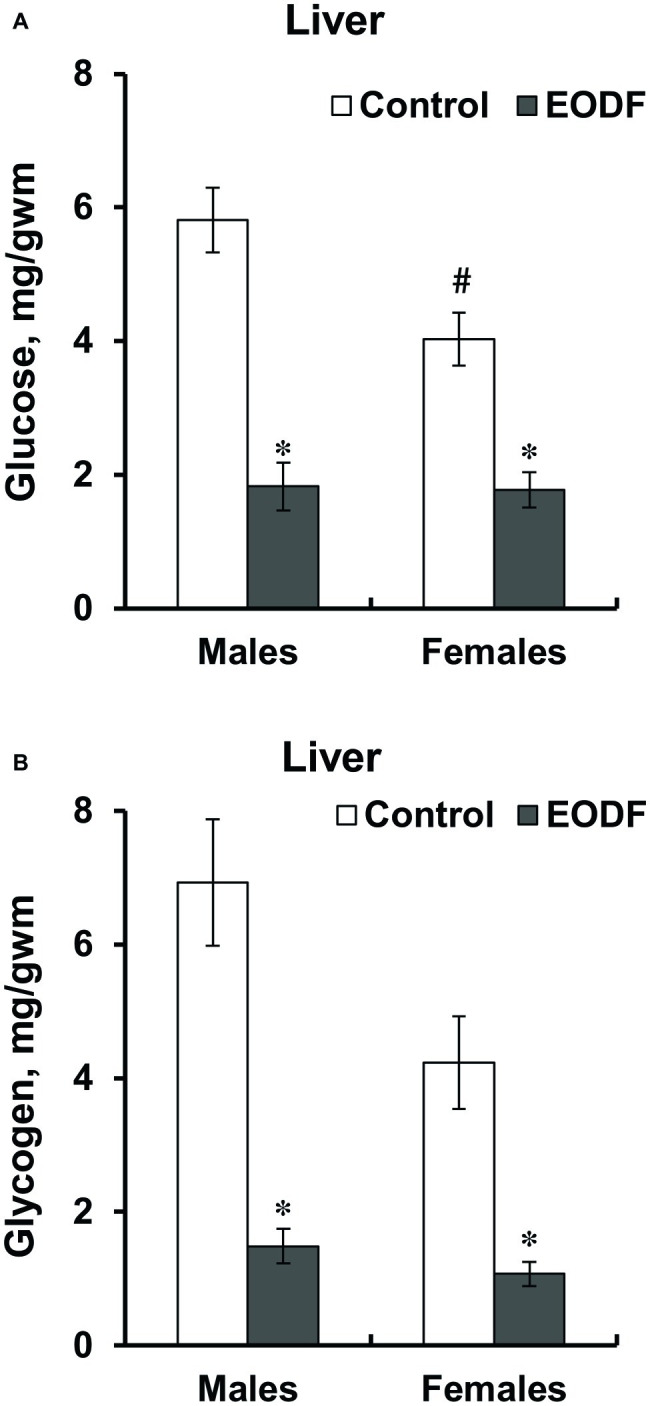
Concentrations of glucose (A) and glycogen (B) in liver of mice fed ad libitum (control) or subjected to an every-other-day feeding regimen (EODF) over 1 month. Here and below data are presented as mean ± SEM, n = 5–7 mice. *Significantly different from the control group (p < 0.05), #significantly different from corresponding group of males (p < 0.05) by Welch’s t test with Benjamini-Hochberg adjustment of p.